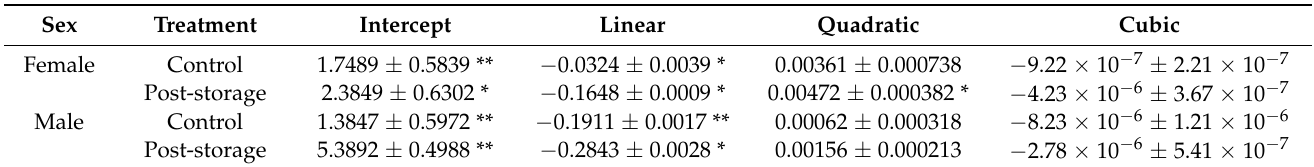
Table 3. Estimates of functional response parameters for Cyrtorhinus lividipennis adults predating on Nilaparvata lugens eggs. Figure 2. Functional responses of post-storage and control adults of Cyrtorhinus lividipennis to Nilaparvata lugens eggs. A: control females, B: post-storage females, C: control males, and D: post- storage males. The data (mean ± SE) represent the numbers of preys consumed by the predator in 24 h; the lines are fitted using the Holling type II equation. * shows a significant difference (inde- pendent sample t -test, p = 0.05).